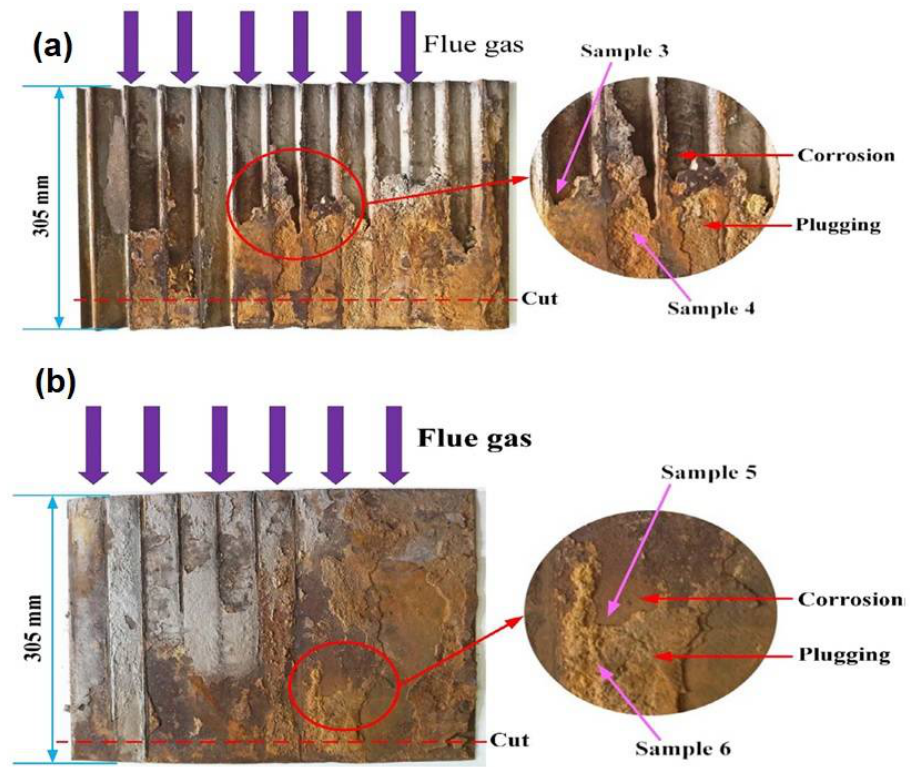
Figure 18. Effect of corrosion on ( a ) corrugated plate and ( b ) positioning plate of air preheater (lower portion) [80].